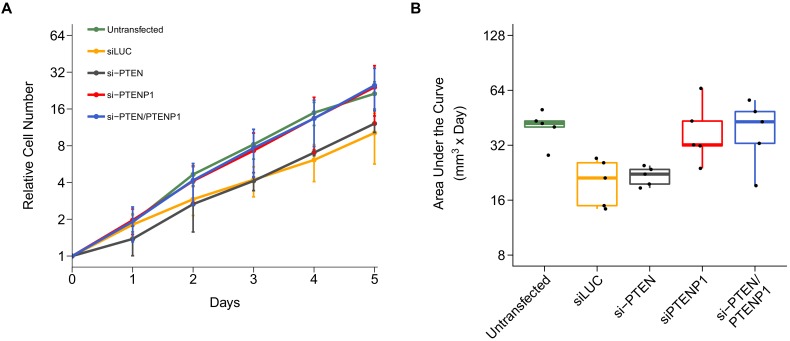
Alternative visualization of cell growth.This is the same experiment as Figure 1. (A) Relative cell numbers were natural log transformed with means reported and error bars represent SD. (B) The area under the curve (AUC) was calculated for each condition of each biological repeat (n = 5). Box and whisker plot with median represented as the line through the box, individual AUC values represented as dots, and whiskers representing values within 1.5 IQR of the first and third quartile (y-axis is natural log scale). Two-way ANOVA interaction between PTEN (targeted or not-targeted) and PTENP1 (targeted or not-targeted) on AUC values: F(1,16) = 0.0015, p=0.970; main effect of PTEN: F(1,16) = 0.033, p=0.858; main effect of PTENP1: F(1,16) = 13.3, p=0.0022. Planned contrasts between siLUC and si-PTEN: t(16) = 0.16, uncorrected p=0.878 with a priori Bonferroni adjusted significance threshold of 0.01, Bonferroni corrected p>0.99; siLUC and si-PTENP1: t(16) = 2.60, uncorrected p=0.019, Bonferroni corrected p=0.115; siLUC and si-PTEN/PTENP1: t(16) = 2.71, uncorrected p=0.016, Bonferroni corrected p=0.093; si-PTEN/PTENP1 and si-PTEN: t(16) = 2.55, uncorrected p=0.021, Bonferroni corrected p=0.128; si-PTEN/PTENP1 and si-PTENP1: t(16) = 0.10, uncorrected p=0.920, Bonferroni corrected p>0.99. Additional details for this experiment can be found at https://osf.io/kjmxj/.